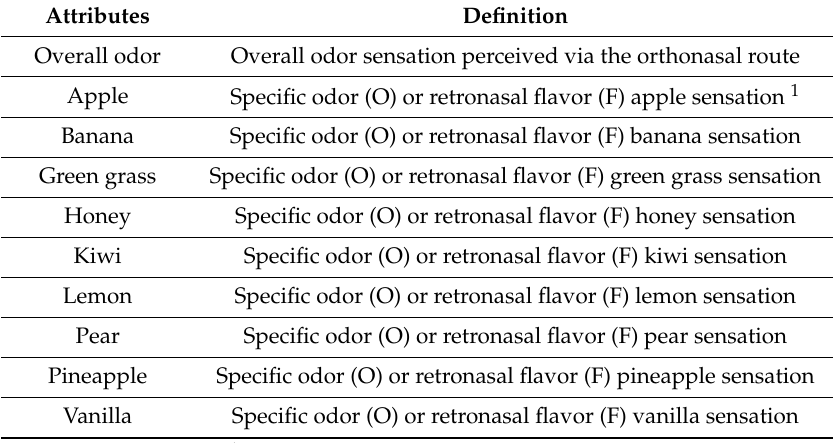
Table 2. Sensory vocabulary used by the sensory